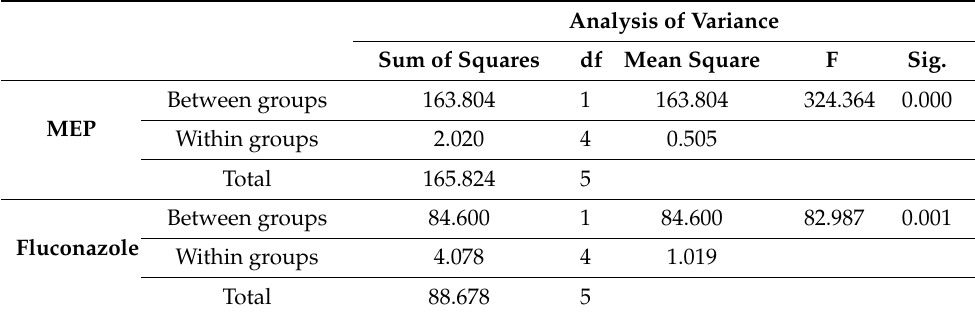
Table 6. Analysis of variance of potential of MEP against fungal